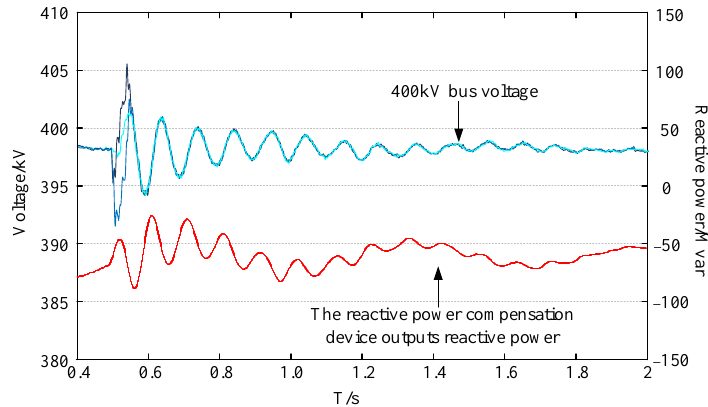
Figure 7. The grid voltage dropped by 2%.